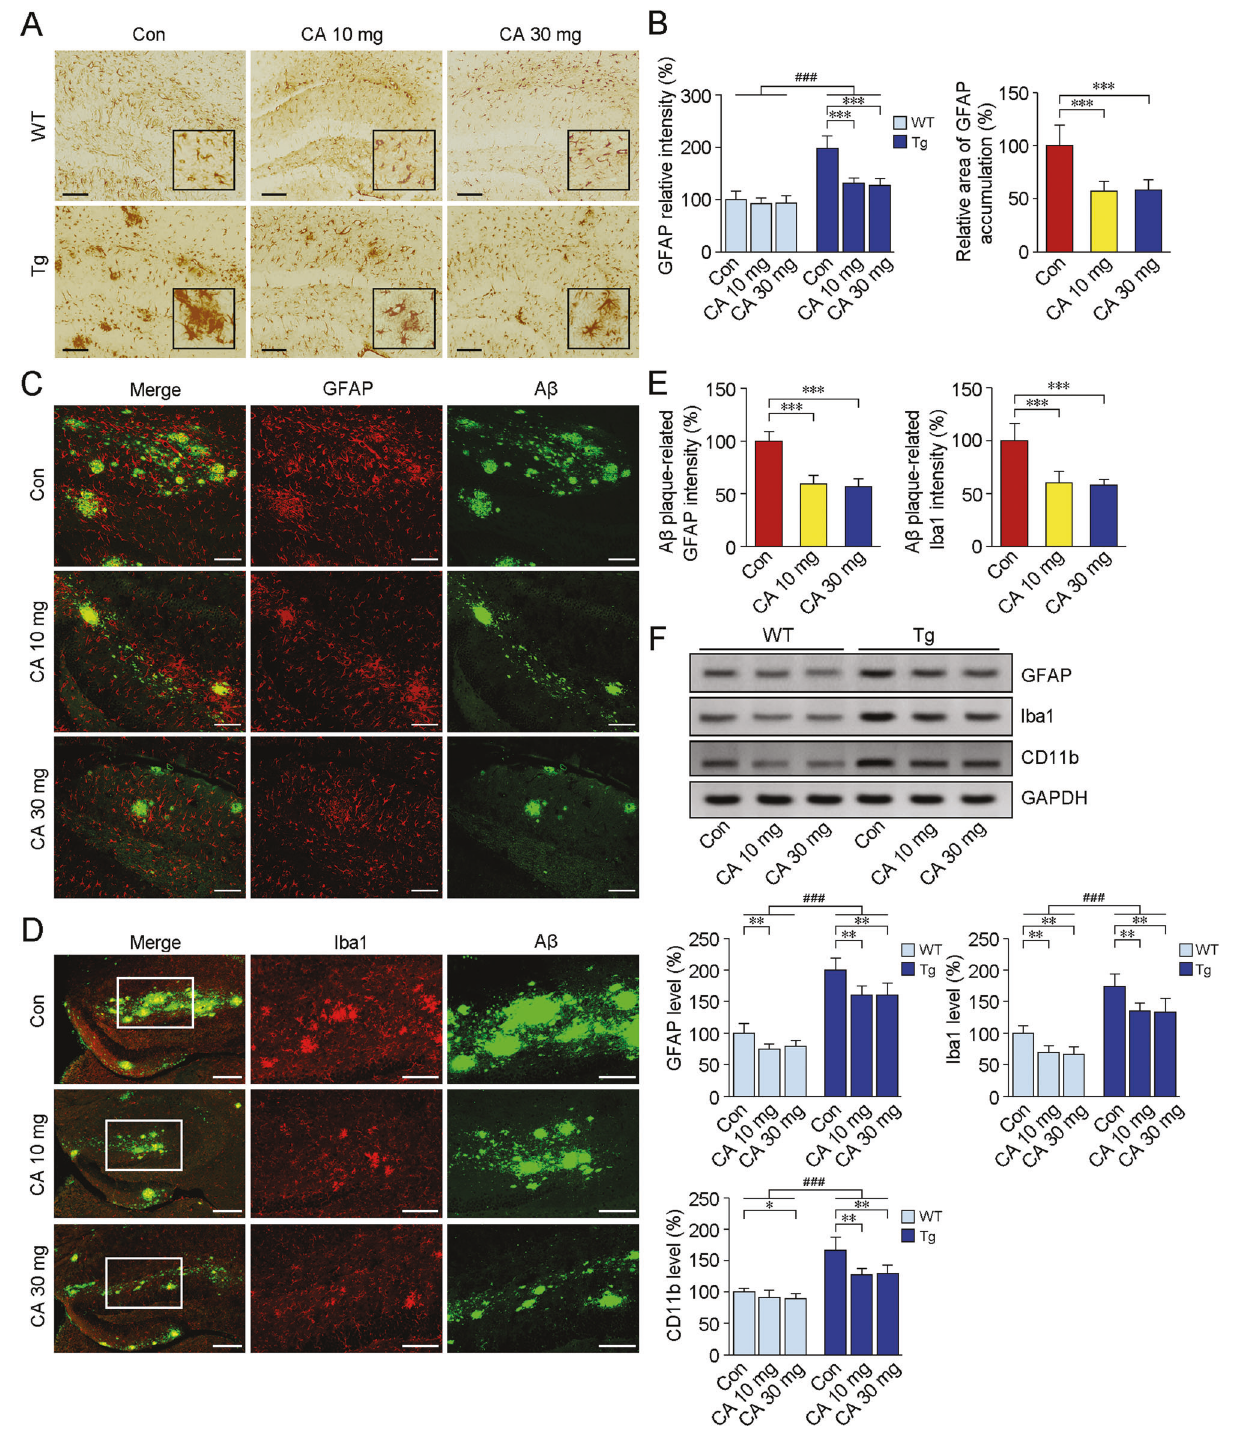
Fig. 5 Effects of CA-SBE β CD NPs treatment on microglial and astrocyte activation in the brains of APP/PS1 mice. APP/PS1 Tg mice and age-matched WT C57BL/6 mice were administered with CA-SBE β CD NPs (loaded with 10 or 30 mg/kg CA) or SBE β CD NPs (vehicle control) for 5 months. A Astrocytes in the hippocampus were detected by IHC with an anti-GFAP antibody. In the brains of Tg mice, astrocytes aggregated and exhibited somatic hypertrophy and thickening of the primary processes. Scale bars: 200 μ m. B Quanti fi cation of the GFAP intensity in WT and Tg mice. C Representative confocal laser scanning microscopy images showing the distribution and localisation of activated astrocytes and A β plaques in the hippocampus. GFAP-labelled astrocytes (red) around A β plaques (green) are shown. Scale bars: 100 μ m. D Double labelling for Iba1 (red) and A β (green) respectively shows the activated microglia and A β plaques in the hippocampus of the Tg mouse. Scale bars: 200 μ m. The high-magni fi cation images in the right panels correspond to the areas indicated in the boxes. Scale bars: 100 μ m. E Quanti fi cation of the relative intensities of GFAP and Iba1. F The protein levels of GFAP, Iba1 and CD11b were examined by Western blot analysis. Blots were repeated at least three times for every condition. * p < 0.05, ** p < 0.01 and *** p < 0.001 vs vehicle-treated mice; ### p < 0.001 vs the WT mice by the one- or two-way ANOVA with post hoc Fisher ’ s LSD tests as appropriate. Values represent the mean ± SD. n = 6 in each group. Cell Death and Disease (2022)